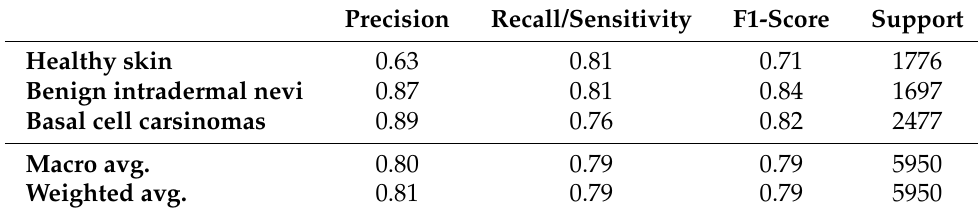
Table 3. Classification report of the pixel classification, slice half model.